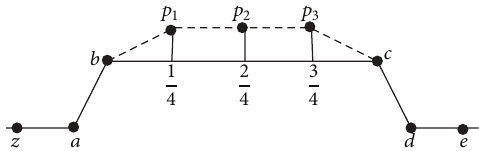
Figure 3: Labeling a sample control polygon. The newly inserted points between old vertices 𝑏 and 𝑐 are referred to as 𝑝 1 , 𝑝 2 , and 𝑝 3